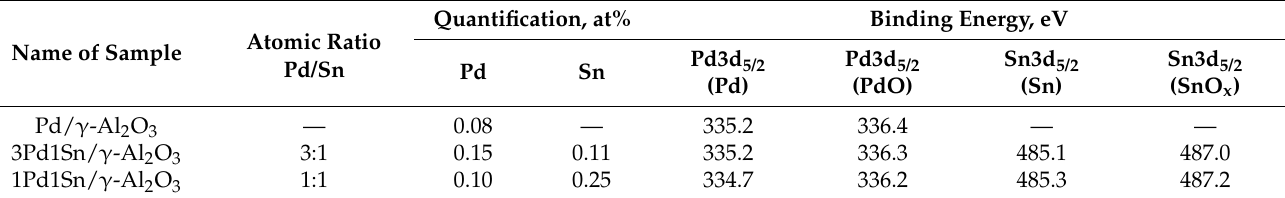
Figure 5. Sn3d 5/2 core-level XPS spectra for 3Pd1Sn/ γ -Al 2 O 3 and 1Pd1Sn/ γ -Al 2 O 3 samples. Decon- volution with two contributions Sn(0) and Sn(4+) is proposed. Table 2. Surface analysis and binding energy for all synthesized samples by